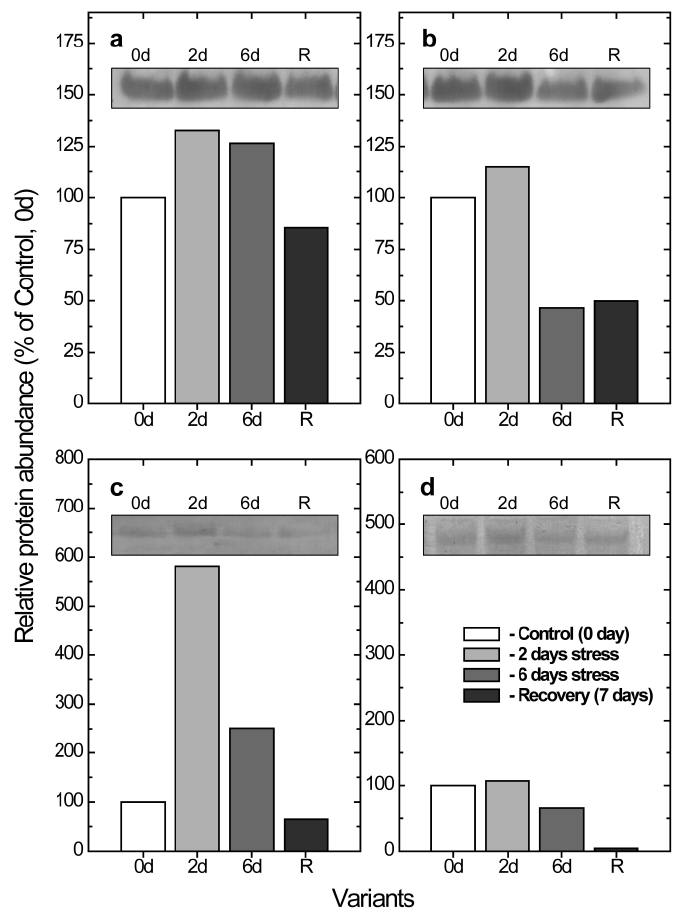
Figure 6. Typical immunoblots (insets) and relative abundance of proton gradient regulation 5 (PGR5) ( a , b ) and plastid terminal oxidase (PTOX) ( c , d ) polypeptides in thylakoid membranes isolated from wt ( a , c ) and lut2 ( b , d ) mutant plants after treatment with high light intensity and low temperature for 2 (2d) and 6 (6d) days, and after recovery for 7 days at control conditions (R). Thylakoid membranes were isolated from leaves of non-treated (0d) and treated plants, separated with sodium dodecyl sulfate–polyacrylamide gel electrophoresis (SDS-PAGE), transferred to polyvinylidene difluoride (PVDF) membrane, and immunodetected with antibodies against PGR5 and PTOX. Presented data are normalized to the relative abundance of the respective polypeptides in the control, non-treated plants (0d).